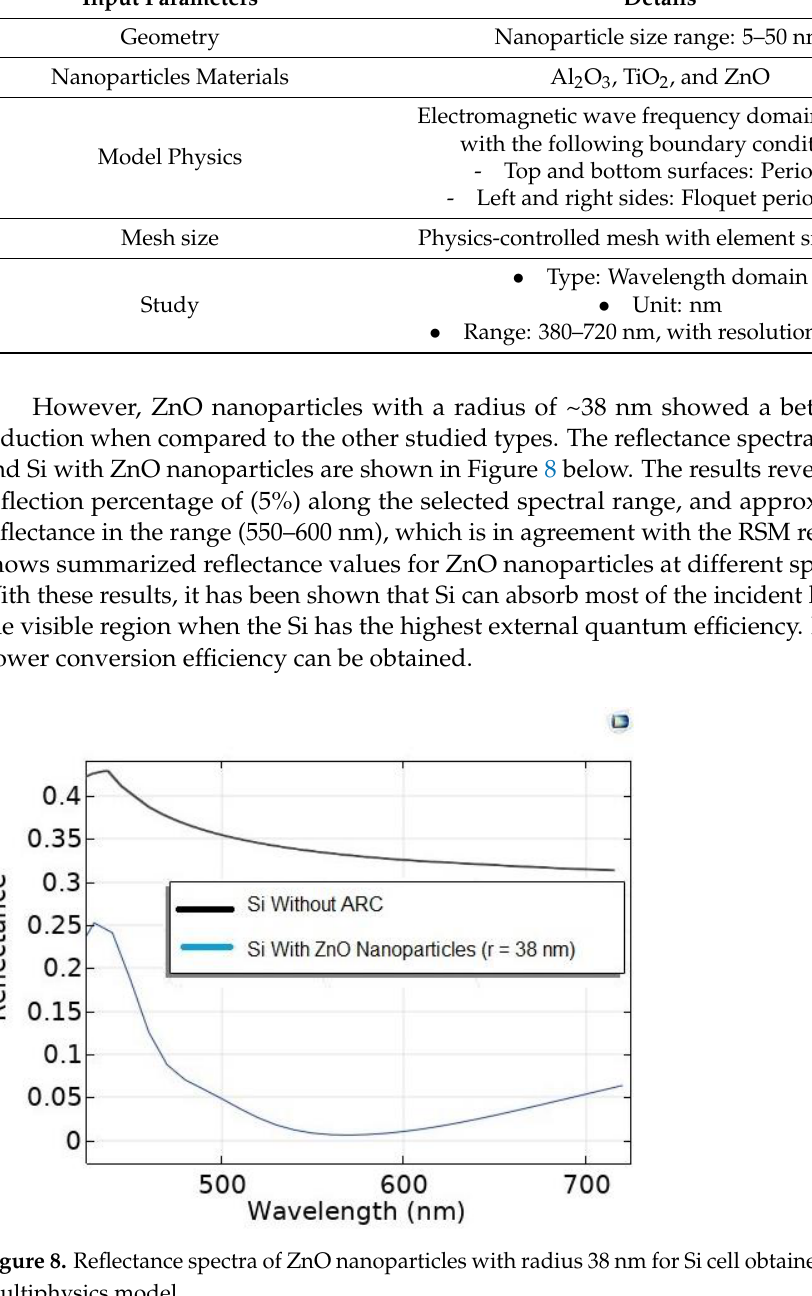
Figure 7. Contour plot of ZnO reflectance vs. wavelength and radius.